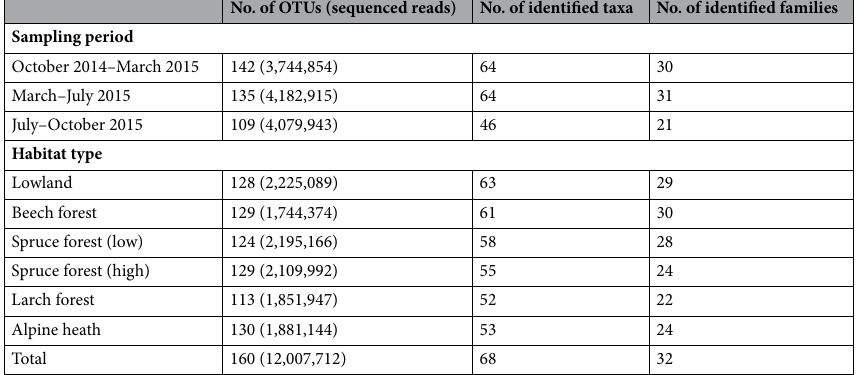
No. of OTUs (sequenced reads) No. of identified taxa No. of identified